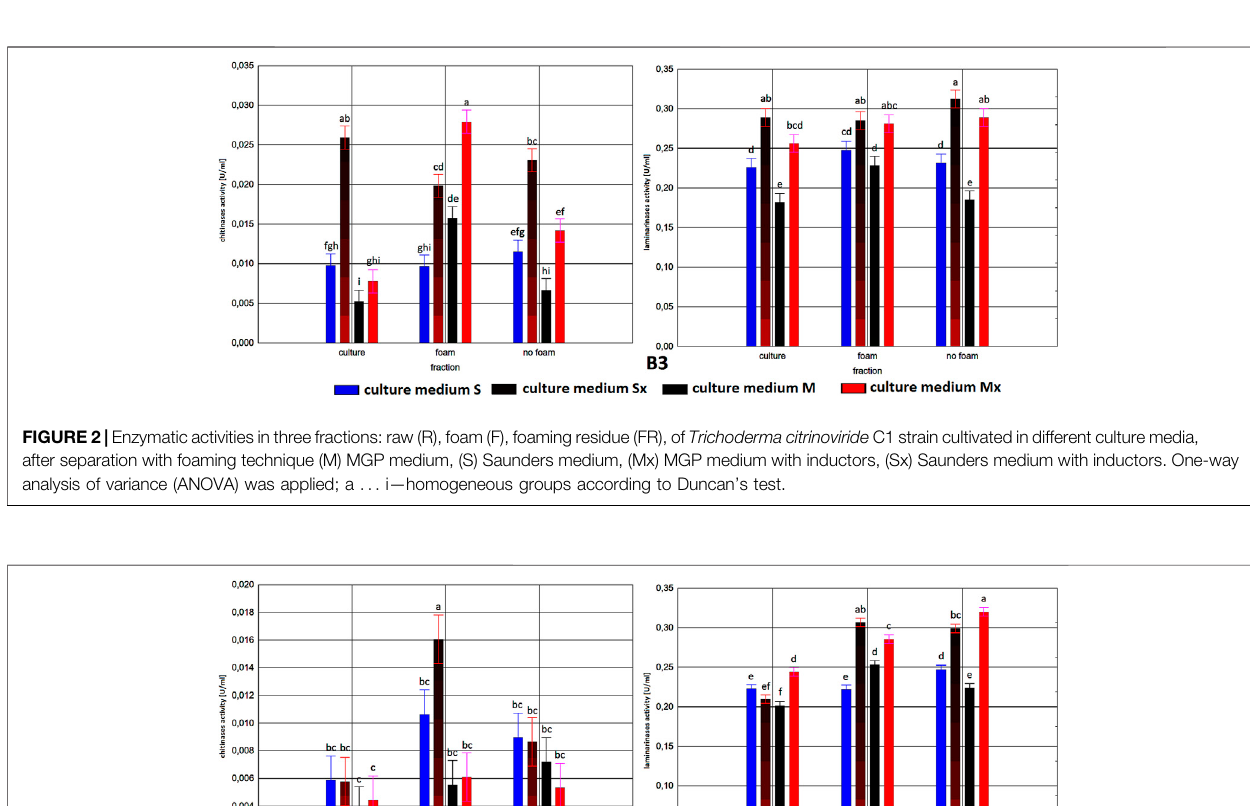
FIGURE1| Enzymatic activities inthree fractions: raw(R), foam (F), foaming residue (FR), of Trichoderma citrinoviride B3strain cultivated in differentculture media, after separation with foaming technique (M) MGP medium, (S) Saunders medium, (Mx) MGP medium with inductors, (Sx) Saunders medium with inductors. One-way analysis of variance (ANOVA) was applied; a ... i — homogeneous groups according to Duncan ’ s test.